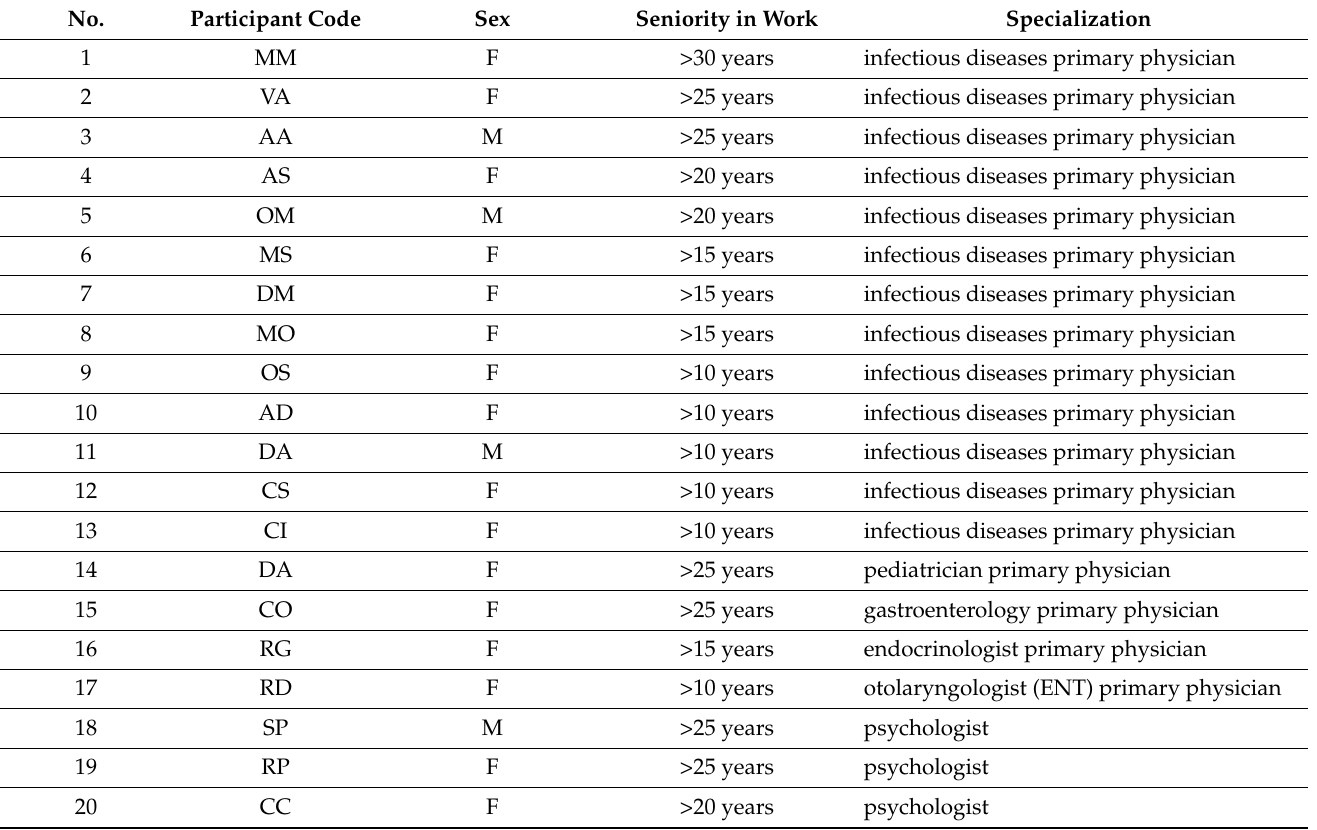
Table 1. The structure of the researched